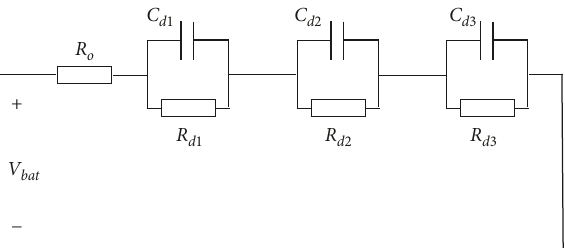
Figure 5: Battery equivalent circuit.